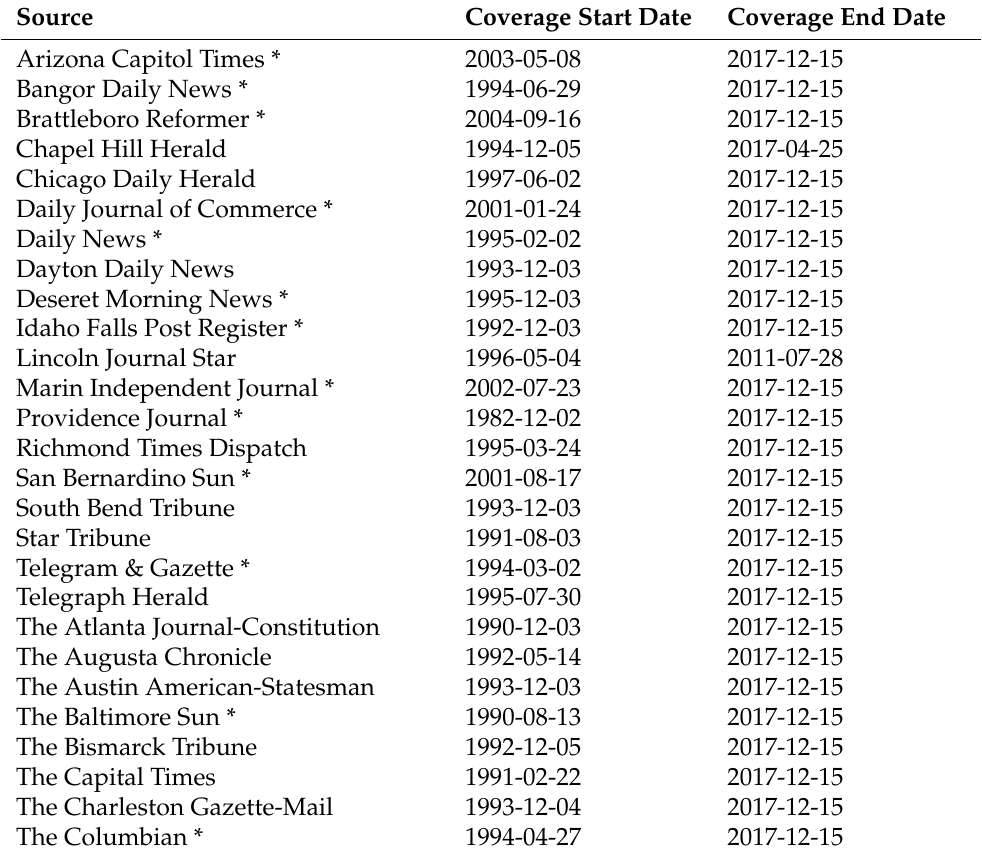
Figure A8. Plot of local Moran’s I, showing the fire frequency plotted against the spatial lag of fire frequency (the average value of fire frequency in areas considered neighbors (using queen’s weighting, the spatial lag value adjusts for observations being neighbors to one another, and thus, will influence each other such that the observed values are not independent, violating the assumption of uncorrelated error terms in ordinary least square regression). Overall, the trend is positive, indicating a geographic pattern of autocorrelation where high values are surrounded by other high values. Numbers indicate location IDs of counties. Table A1. Period of coverage available by newspaper; most sources overlapped from 1997 to 2017, which was the period of analysis for the natural disasters. Note: * indicates sources included in the wildfire case